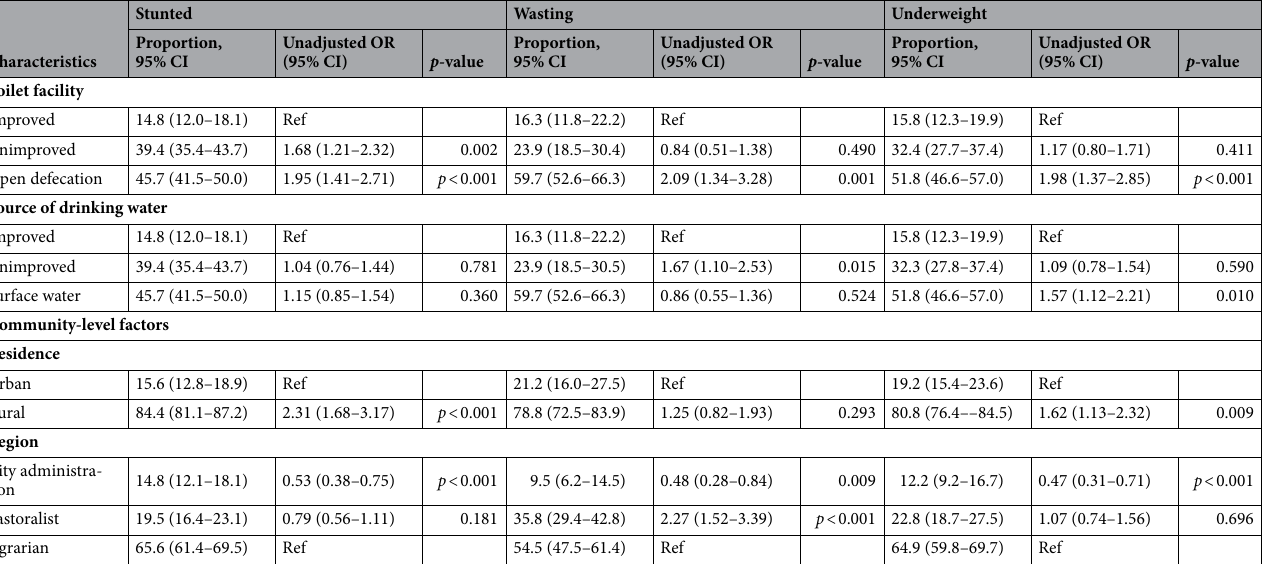
Table 2. Bivariable multilevel logistic regression analysis of factors associated with childhood stunting, wasting, and underweight among children aged 0–23 months in Ethiopia, EMDHS